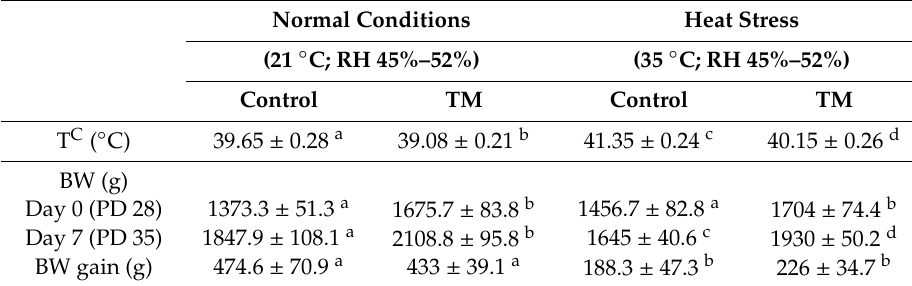
Table 3. E ff ects of post-hatch heat stress for 7 days (post-hatch day (PD) 28 to 35) on cloacal temperature (T C ), body weight (BW), and BW gain in broiler chickens subjected to embryonic thermal manipulation and